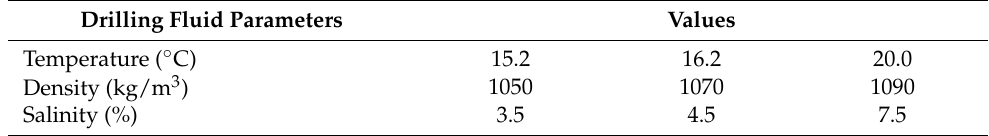
Table 2. Varied parameters of drilling fluids for sensitivity analysis his is a